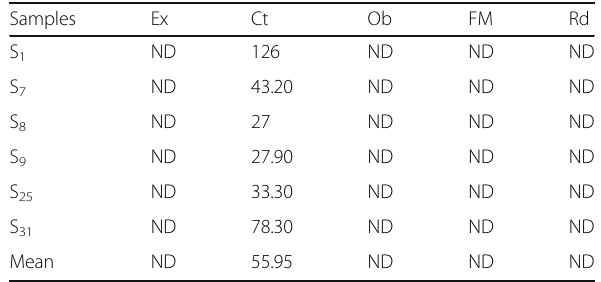
Table 5 Arsenic fractionation results (ppm)